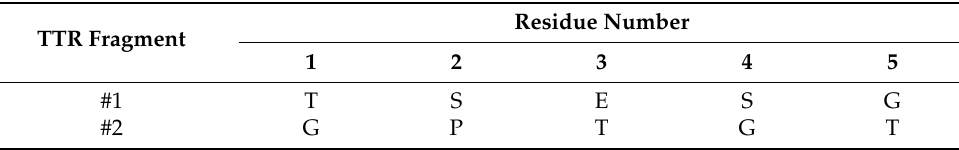
Table 1. Identification of transthyretin peptides upon plasmin digestion by N-terminal sequencing. Band 1 starts at the amino acid residue 49, whereas band 2 starts at the first amino acid residue in the transthyretin polypeptide chain, indicating that band 1 corresponds to the 49–127 C-terminal fragment and band 2 to the 1–48 N-terminal fragment.